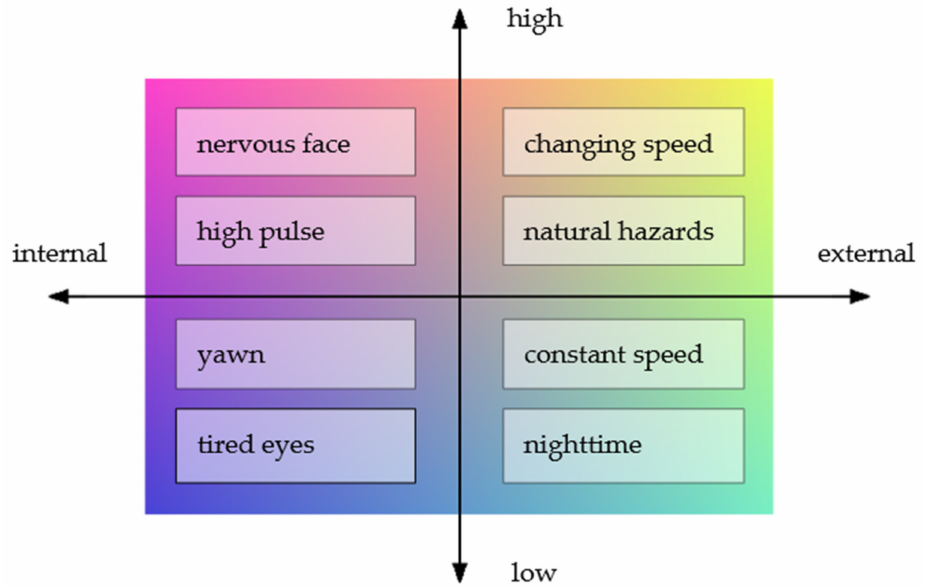
Figure 8. Factors affecting the quality and safety of